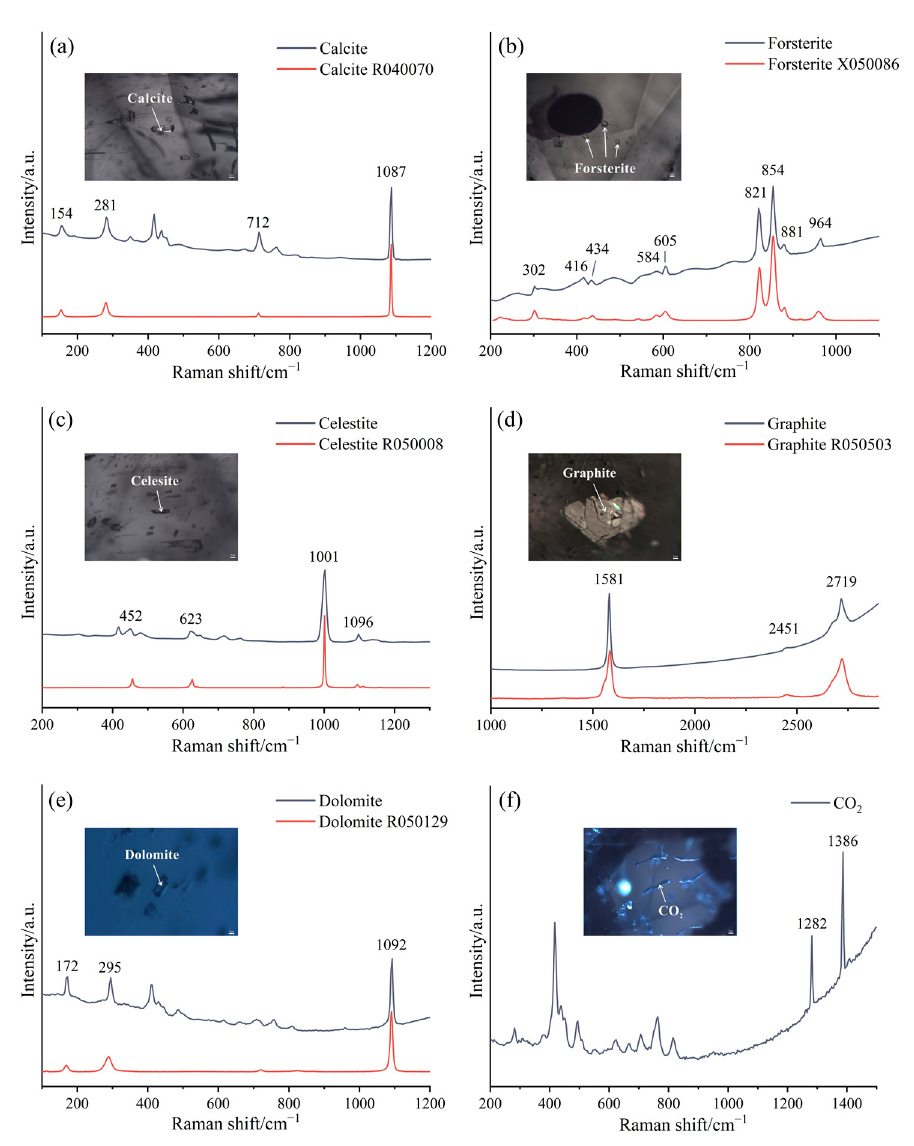
Figure 5. The Raman spectra of inclusions in taaffeite samples. ( a ) calcite; ( b ) forsterite; ( c ) celestite; ( d ) graphite; ( e ) dolomite; ( f ) CO 2 . Subfigures in each figures indicated the Raman test locations.